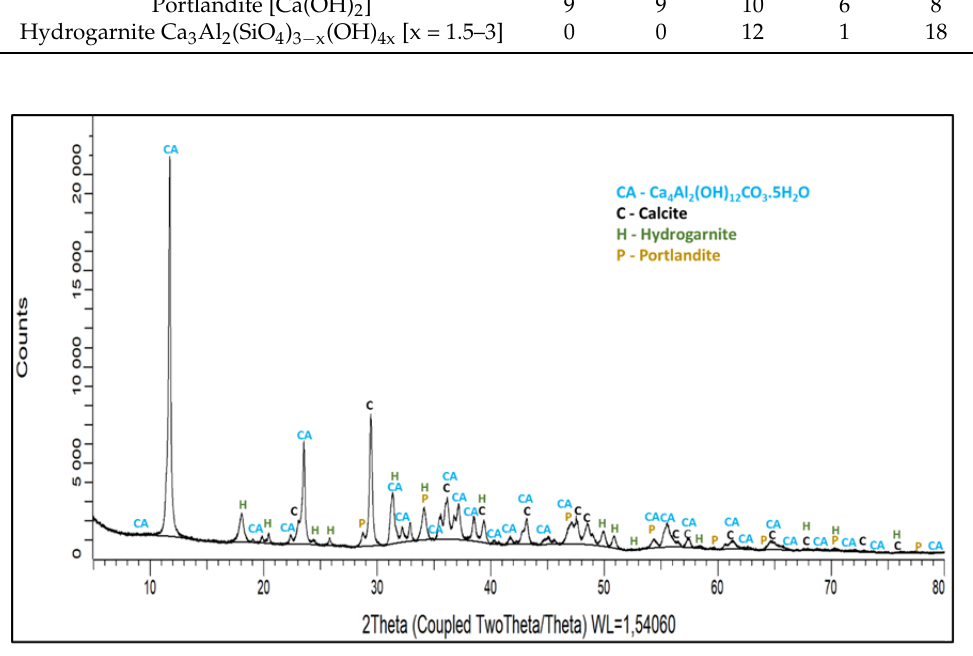
Figure 13 . XRD spectrum for desilication residue from test no. 6 . Figure 13. XRD spectrum for desilication residue from test no.